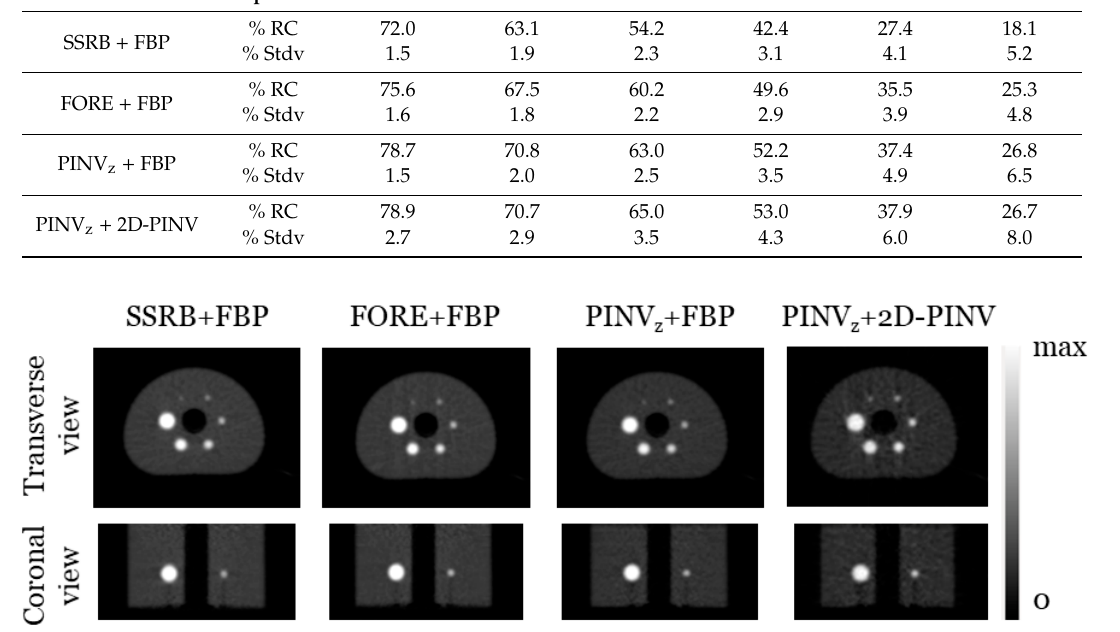
Figure 11. Transverse FBP and 2D-PINV images from data rebinned with PINV, FORE, and SSRB for the clinical IQ NEMA phantom.